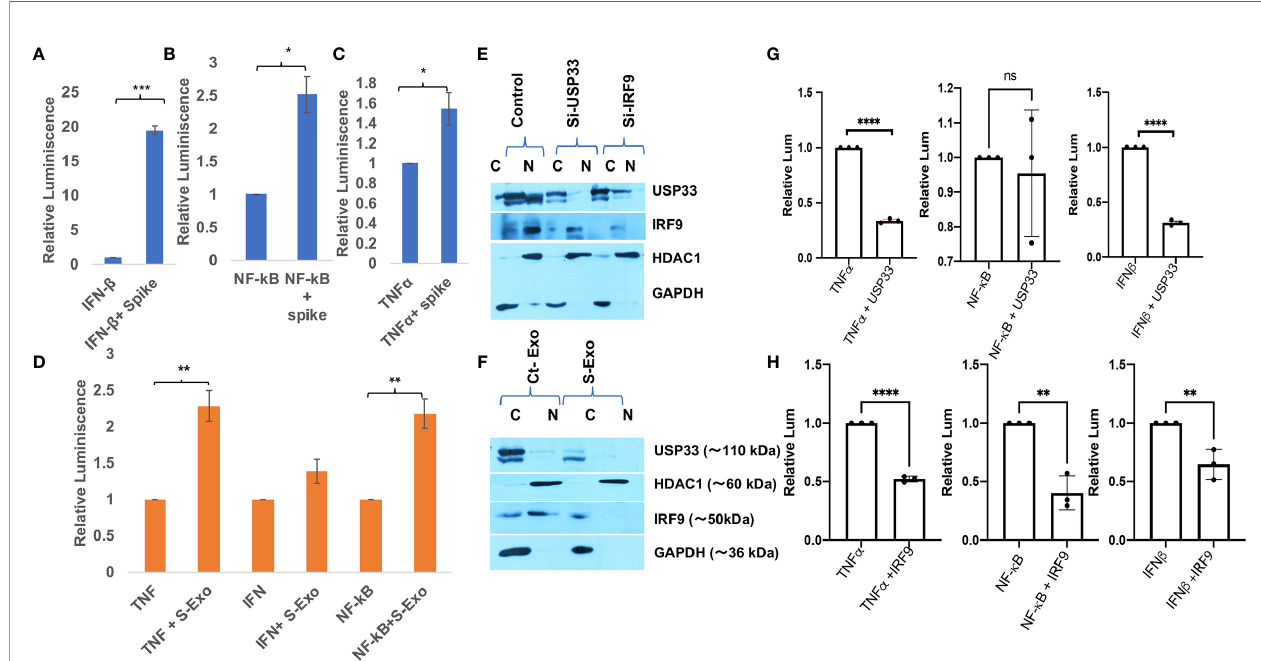
FIGURE 6 | Impact of Spike protein on host cytokine gene expressions. (A – C) Impact of direct Spike gene transfection on promoter activity of IFN- b , NF- k B and TNF a . These three plasmids (1µg each) were co-transfected with 2µg of Spike gene plasmids in HEK-293T cells and after 24 hours, cells were harvested and dual luciferase assay were performed. 500 ng of Renilla luciferase plasmids were also transfected and their luciferase values have been used as normalizer in all the experiments. (D) Graph bars showing the result of treatment of S-exosomes on the promoter activity of TNF a , IFN- b and NF- k B. Luciferase assay were done in HEK-293T cells as described in previous experiment. (E) Immunoblot analysis showing lesser concentration of IRF9 in nuclear fraction of S-exo treated microglia cells. (F) Immunoblot images showing the impact of USP33 siRNA and IRF9 siRNA on nuclear concentration of IRF9. (G) Graph bars showing relative luminescence in USP33 overexpressed cells. 1µg of USP33 plasmids were co-transfected with 1µg of all three plasmids (IFN- b , NF- k B and TNF a ) in their respective wells. (H) Graph bars showing relative luminescence in IRF9 overexpressed cells. 1µg of IRF9 plasmids were co-transfected with 1µg of all three plasmids (IFN b , NF- k B and TNF a ) in their respective wells. After 24 hours, cells were harvested and dual luciferase assay were performed. Dual luciferase assays were performed at least three times to get the average values and are displayed as graph bars. Results shown as mean and mean ± S.E.M. Student ’ s t-test have been used to calculate the statistical signi fi cance, indicated as * means p values <0.05, ** for p values <0.005, *** for p values <0.0005, **** for p values